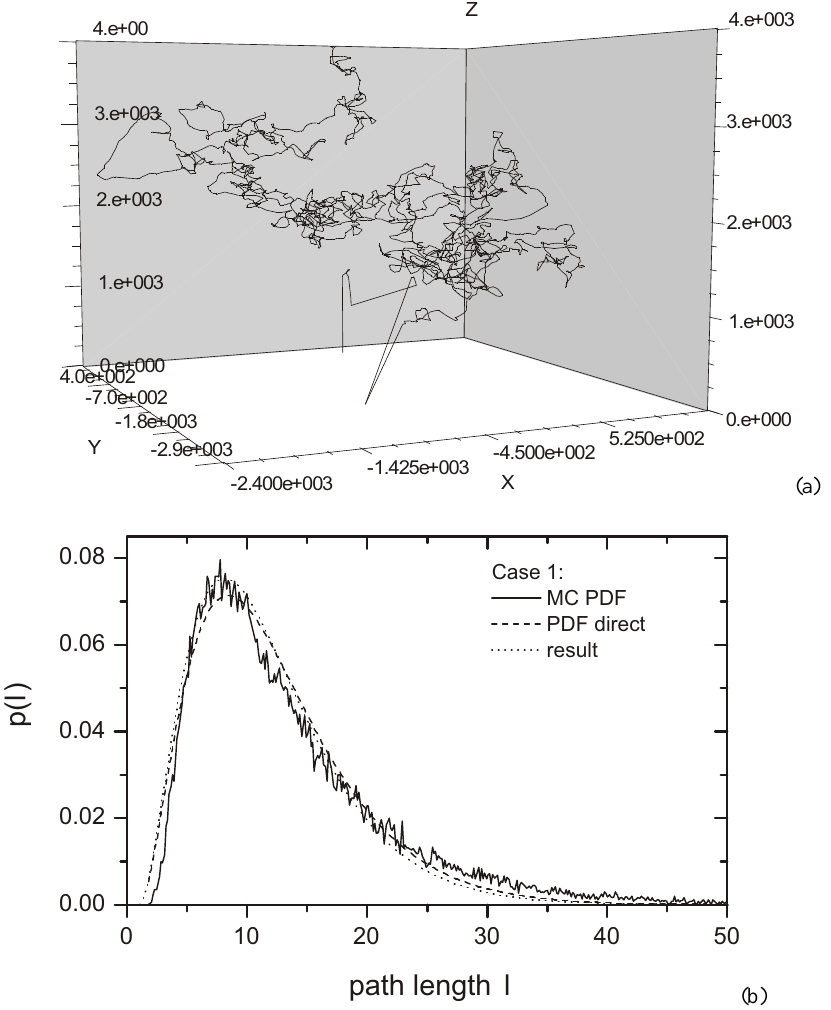
Fig. 1. The MC path length distributions and validation results for the two cases. Panels (a) and (c) show exemplary photon trajectories for the Cases 1 and 2 discussed in Sect. 4, respectively. The atmosphere is cut at the cloud top, axis units are in m. While panel (a) shows the photon diffusion in the extended cloud layer, reflection between the two cloud layers can be seen in panel (c). The panels (b) and (d) show the resulting path length distributions for 1 million photons. Path lengths are given in units of the vertical path. Panel (b) shows a typical broad distribution, while the reflection between the two layers generate a bimodal distribution for Case 2. To fit these PDFs, a Gamma distribution is used for Case 1 (b) and a log-normal distribution is used for Case 2 (d). Included is the results of a direct fit of the Monte Carlo PDF with the PDF model (labelled as PDF direct). This comparison demonstrates the validity of the PDF model. Good agreement is found for Case 1; however, the Gamma function cannot follow exactly the rising flank which starts at higher path lengths and is steeper. The single peaked PDF model does not match the two modes of the distribution for Case 2. Finally, the results of the retrieval, using the modelled transmissions, is included (labelled as result). For Case 1 the result is similar to the PDF direct result. For Case 2 there is quite a difference between the two retrieved log-normal distributions. The result from the fit with the transmissions looks closer and the moments, see Table 2, are better matched than for the PDF direct fit, which is “misled” by the bimodal form (continues next